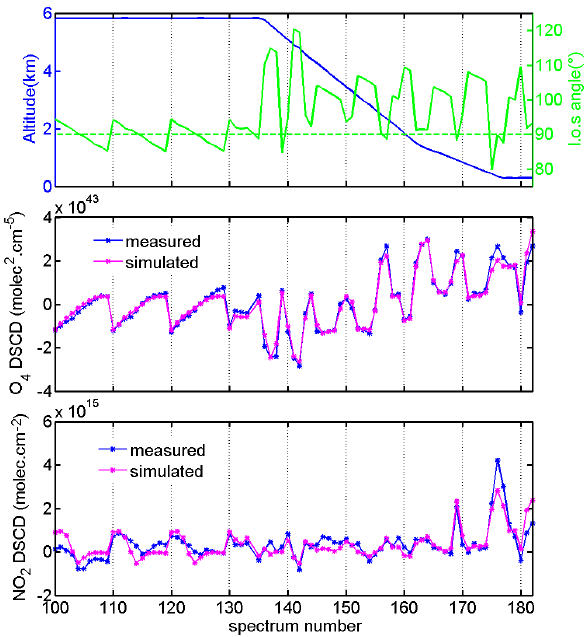
Fig.10. Comparisonoftheaerosolextinctionprofileretrievalusinglinear(left)andlogarithmic(right)weightingfunctionsforthesounding of the as0831 flight (8 April 2008). For the same a priori, the logarithmic retrieval agrees better with an extinction profile calculated from in situ size distribution. Averaging kernels indicate also a higher sensitivity of the retrieval to the true state in the logarithmic case.